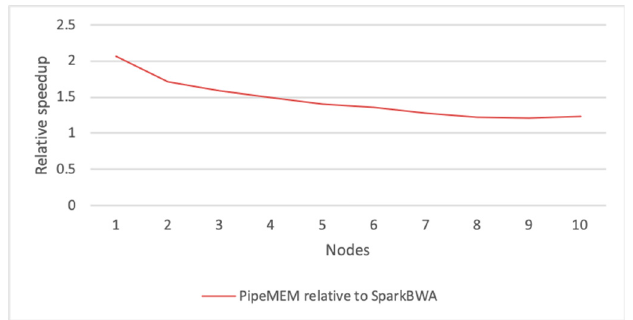
Figure 12. Relative speedup of PipeMEM compared with SparkBWA (including the pre-processing and the main computation). Relative speedup of PipeMEM to SparkBWA as a whole. There is a flatter trend in this line. The relative speedup ends at about 1.2×.